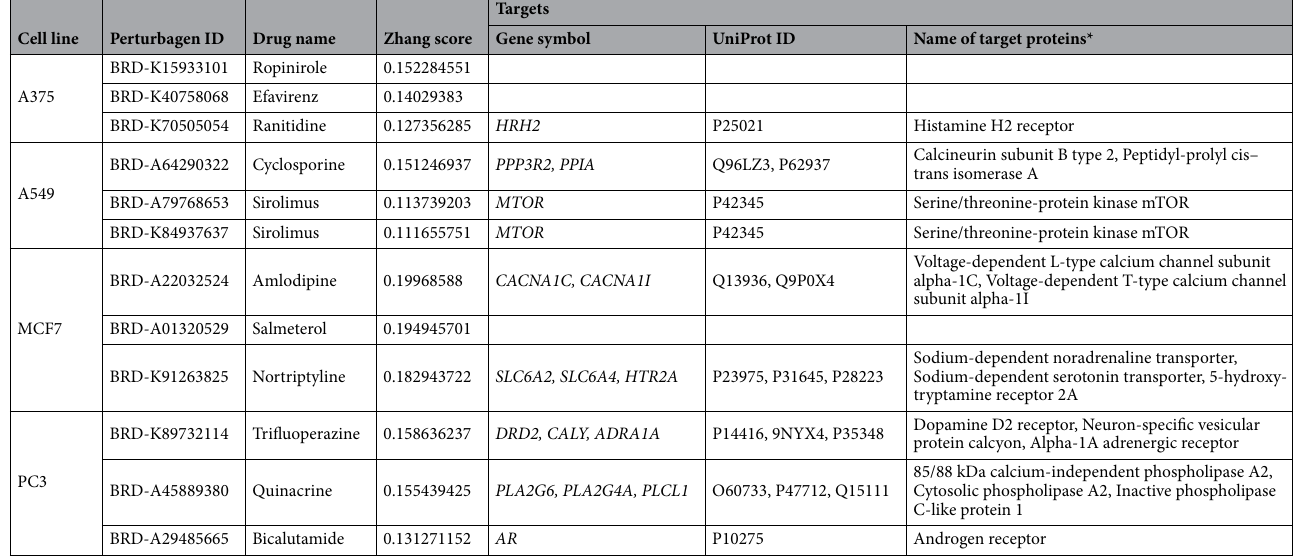
Table 1. Comparison results of connectivity score using LINCS L1000 dataset. *Filtered option: ‘antagonist or inhibitor, human protein, pharmacological action = yes’ were used.